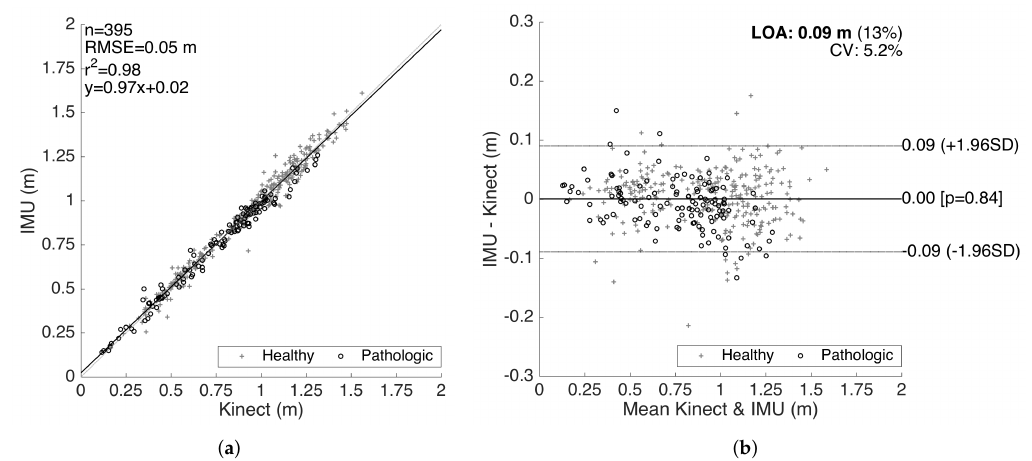
Figure 14. Stride length validation. ( a ) correlation plot and ( b ) Bland–Altman plot.